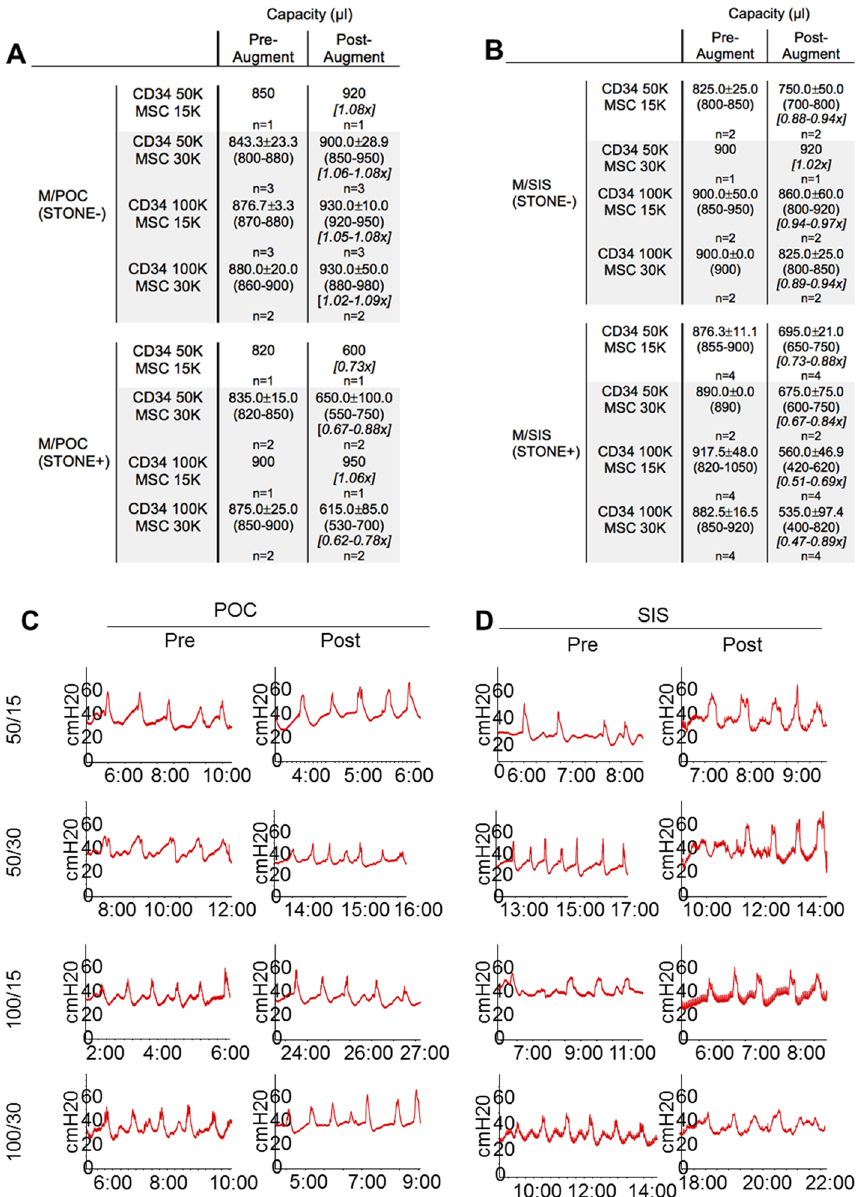
Figure 5. Urodynamic testing on male rat bladders pre- and post-augmentation with ( A ) POC or ( B ) SIS scaffolds seeded at a specific cellular concentration (cells/cm 2 ) with MSC and CD34 + HSPC at varying ratios. Male graft groups are further divided into S− and S+ animals, separated due to the effect bladder stones may have on the actual bladder capacity. A/B) Tables display the mean filling capacity (μl) and range in post- augment/pre-augment capacity ratios of the bladders (n = 2–6 before subsets). Rats in the M/POC (S−) construct were the only group out of 4 to achieve post-augment/pre-augment ratios over 1.0 × in all seeding groups. ( C , D ) UDS readings are from a single group individual and are representative of the group as a